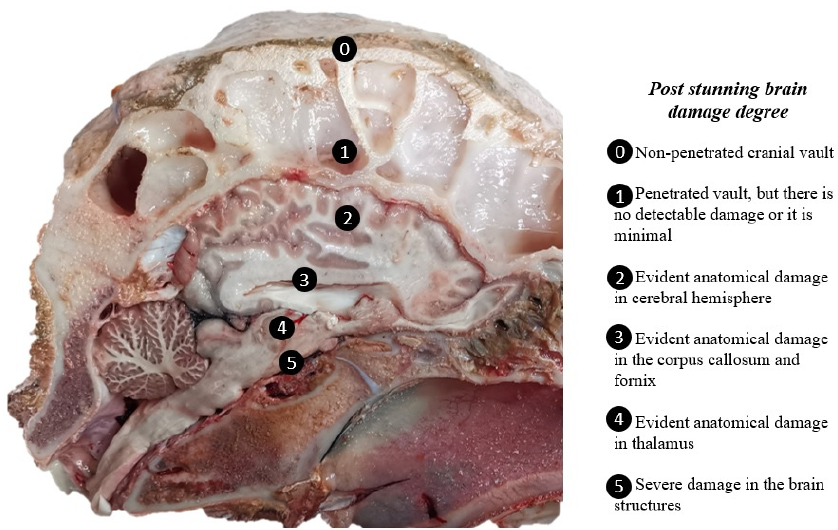
Figure 1. Midsagittal section of a buffalo head showing the post-stunning head and brain damage degree classification proposed in this study.